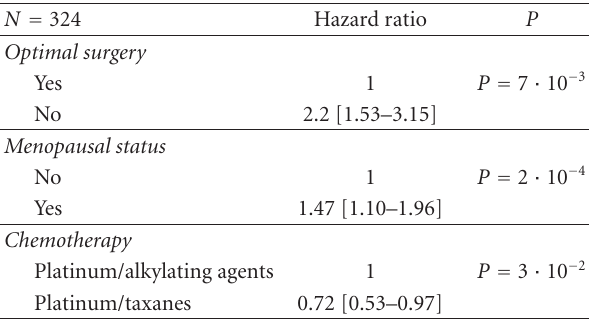
Table 3: Multivariate analysis of overall survival (Cox